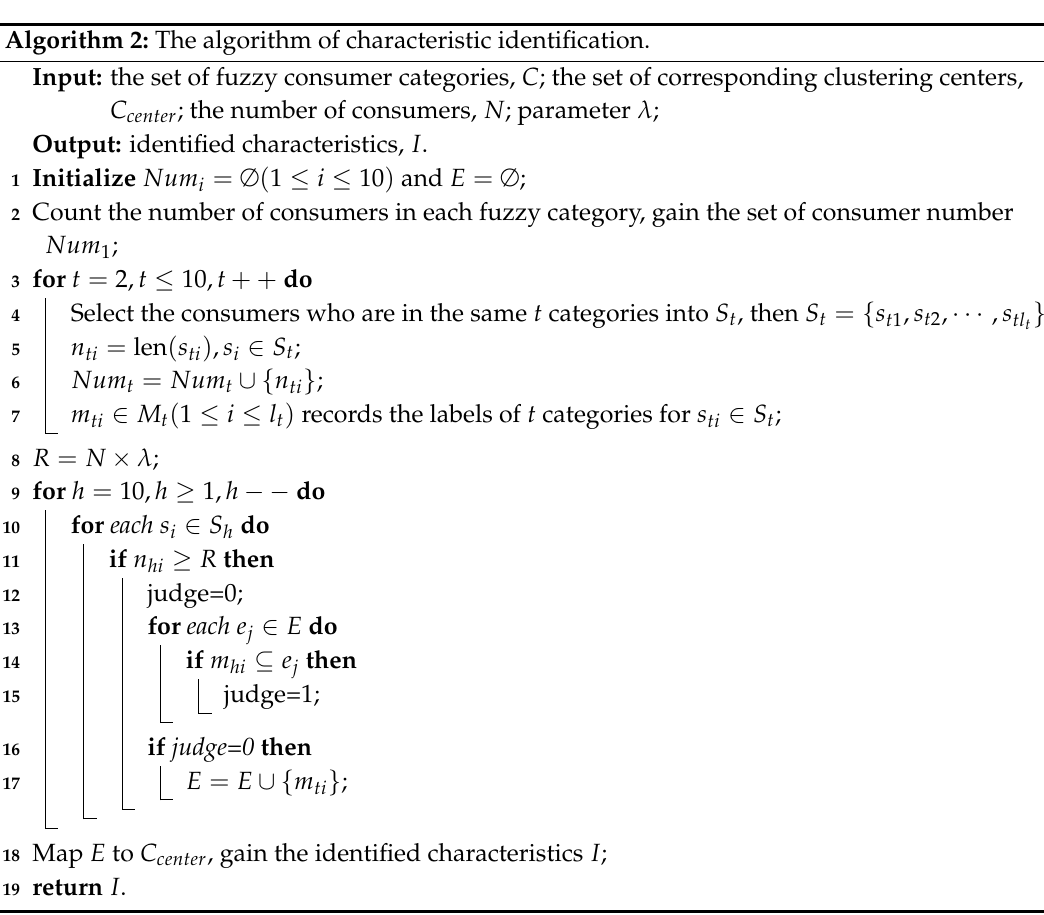
Algorithm 2: The algorithm of characteristic identification.